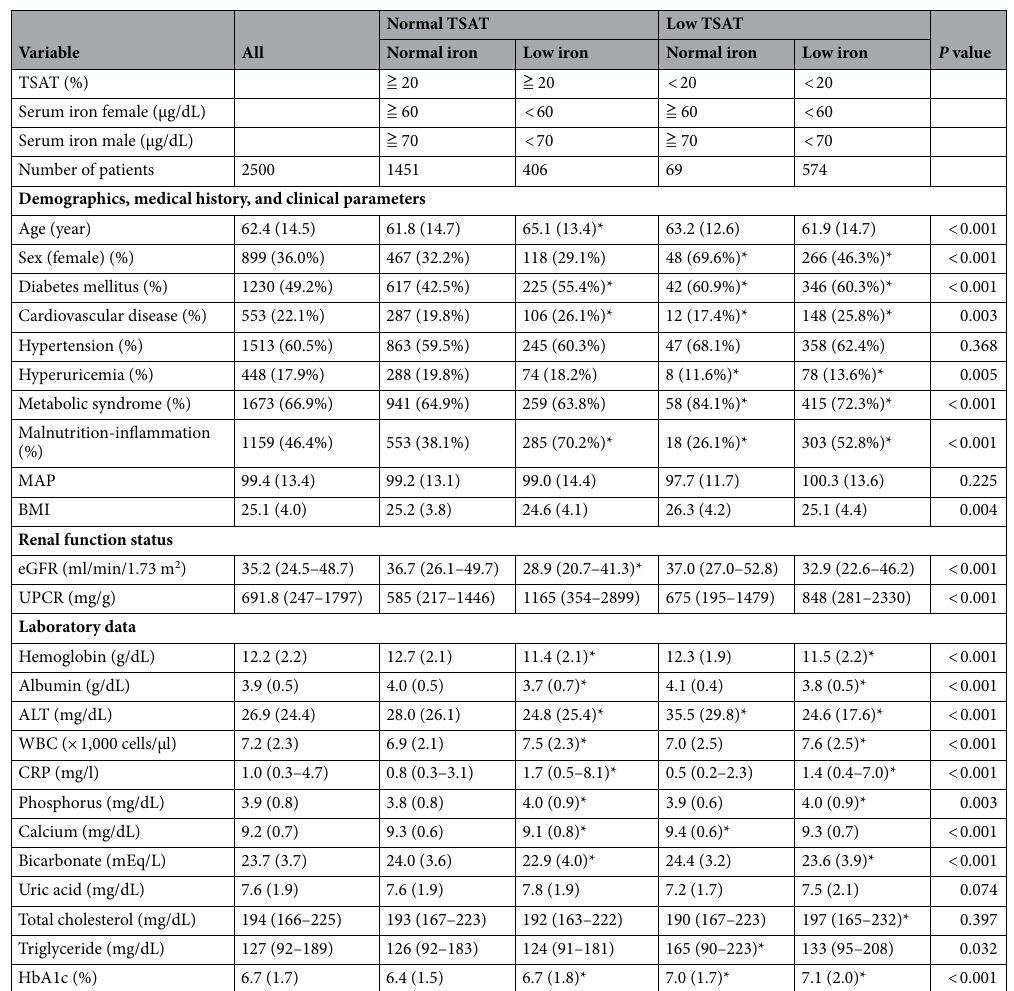
Table 1. Characteristics of CKD patients divided by TSAT and serum iron. Data were presented as mean (standard error), median (interquartile range), or count (percentage). P value column meant differences among groups (< 0.05 was significant). *Meant significant difference (P < 0.05) compared with normal TSAT normal iron group in post hoc analysis. The significance of differences for normally-distributed continuous variables among groups was tested using one-way ANOVA with post hoc analysis by Fisher’s least significant difference test and, for non-normally-distributed continuous variables, it was tested using Kruskall–Wallis analysis with post hoc analysis by Dunn–Bonferroni method. The difference in the distribution of categorical variables among groups was tested using the Chi-square test with post hoc analysis by Bonferroni method.